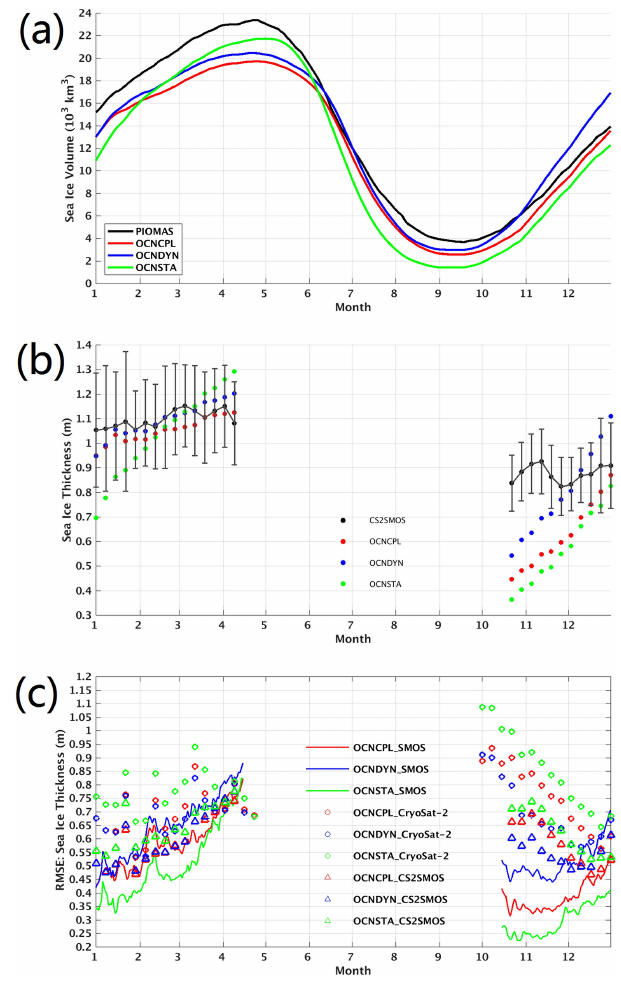
Figure 9. Time series of (a) total sea ice volume, (b) spatial mean sea ice thickness and (c) the RMSE of sea ice thickness with respect to the satellite-retrieved observations in 2012. The black, red, green and blue lines in (a) denote total sea ice volume of the PIOMAS data, the OCNCPL run, the OCNSTA run and the OCNDYN run, respectively. The black, red, green and blue dots in (b) denote sea ice thickness of the CS2SMOS observations, the OCNCPL run, the OCNSTA run and the OCNDYN run, respectively. The black bar in (b) represents the observational uncertainties of the CS2SMOS data. The red, green and blue masks in (c) denote sea ice thick- ness RMSE of the OCNCPL run, the OCNSTA run and the OC- NDYN run with respect to the SMOS observations in a thin ice ( < 1m) region (line), the Cryosat-2 observations (circle) and the CS2SMOS observations (triangle), respectively. Model grid points without available observations are not included in the sea ice thick- ness RMSE calculation. PIOMAS: Pan-Arctic Ice Ocean Modeling and Assimilation System; SMOS: Soil Moisture Ocean